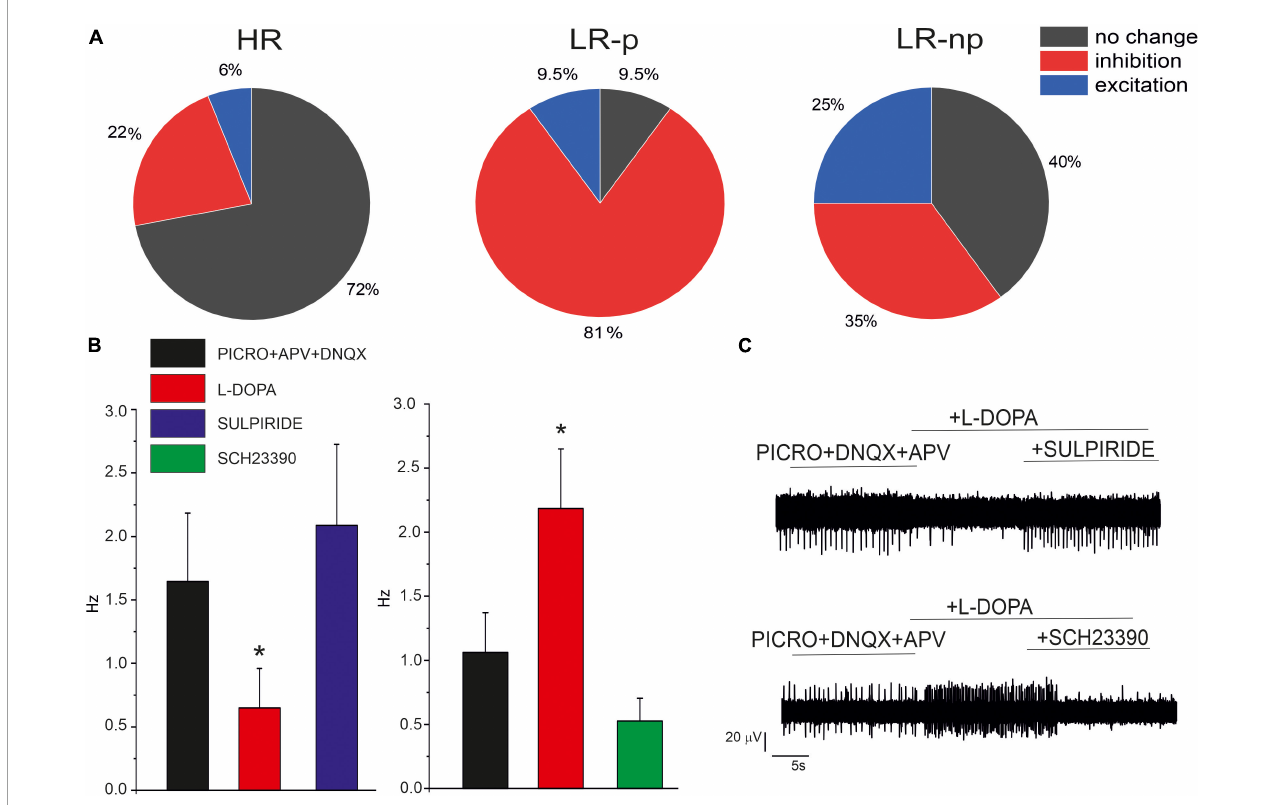
FIGURE7 Effects of L-DOPA and D 1 /D 2 antagonist on cultured midbrain DA neurons. (A) Pie plots of the percentage of neurons responding with inhibition, no change or excitation, in the HR, LR-p, and low-rate non-pacemaking (LR-np) subpopulations after L-DOPA administration. (B) Effect of D 1 and D 2 receptor antagonists, SCH-23390) and sulpiride after L-DOPA administration. (C) Representative AP traces in the indicated experimental conditions. * p <